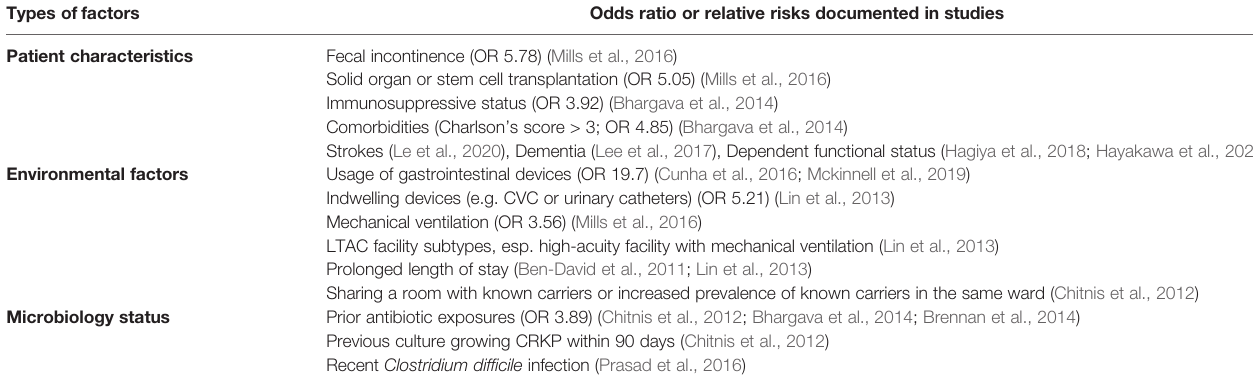
TABLE 4 | Risk factors for CRE acquisition in